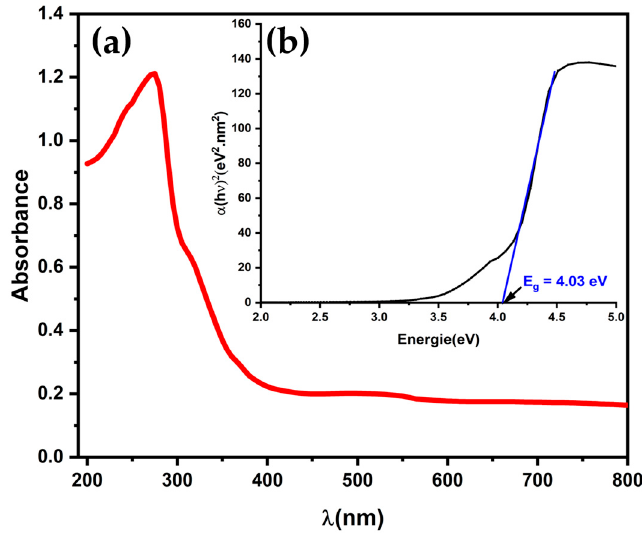
Figure 5. ( a ) UV-Vis absorption spectra of Li 0.95 Ta 0.76 Nb 0.19 Mg 0.15 O 3 . ( b ) Tauc plot of Li 0.95 Ta 0.76 Nb 0.19 Mg 0.15 O 3 .